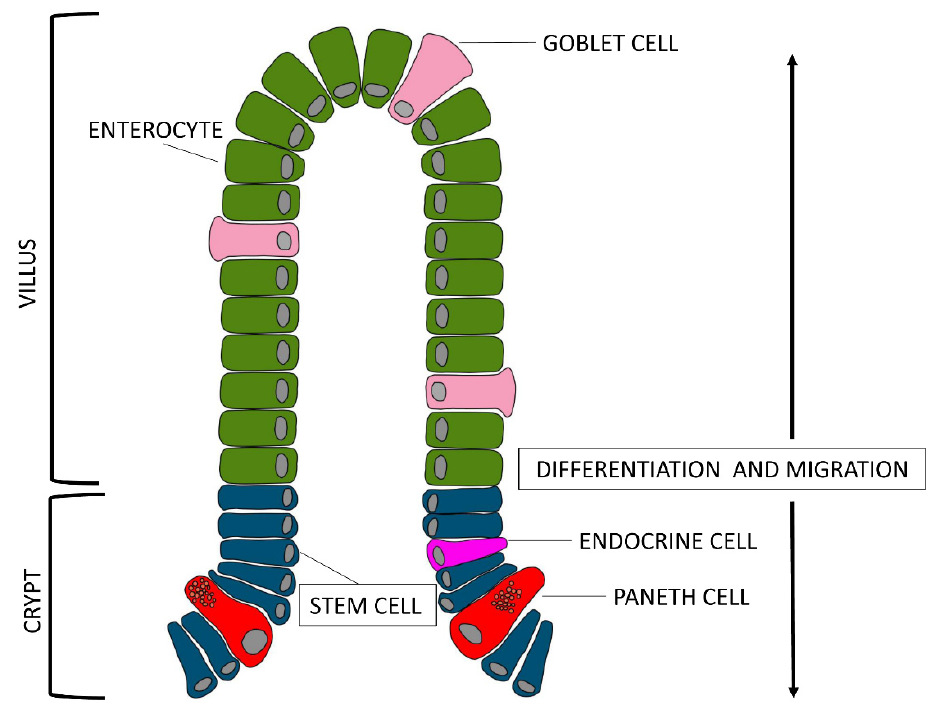
Figure 2. After stem cell mitosis ( blue cells ), some epithelial cells go towards the apex of the villi and differentiate into enterocytes ( green cells ) or mucous cells ( light pink cells ); some others migrate down the crypts and differentiate into Paneth cells ( red cells ) or endocrine cells ( pink cell ).